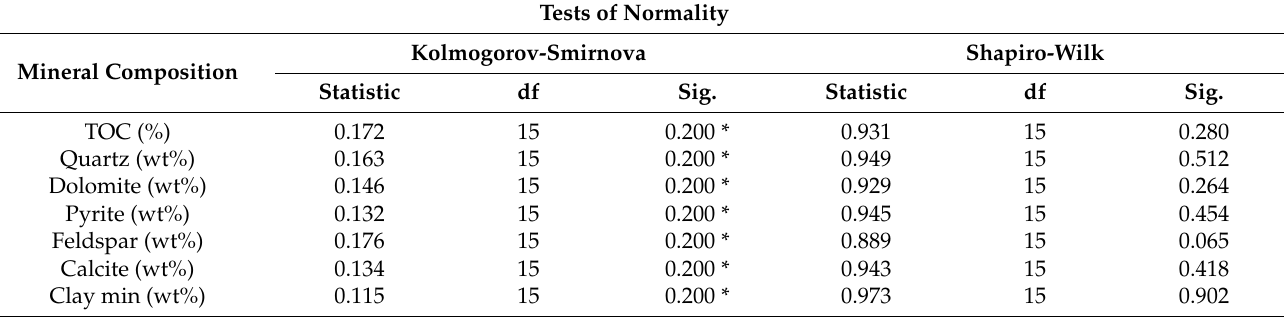
Table A1. Analysis of mineral composition